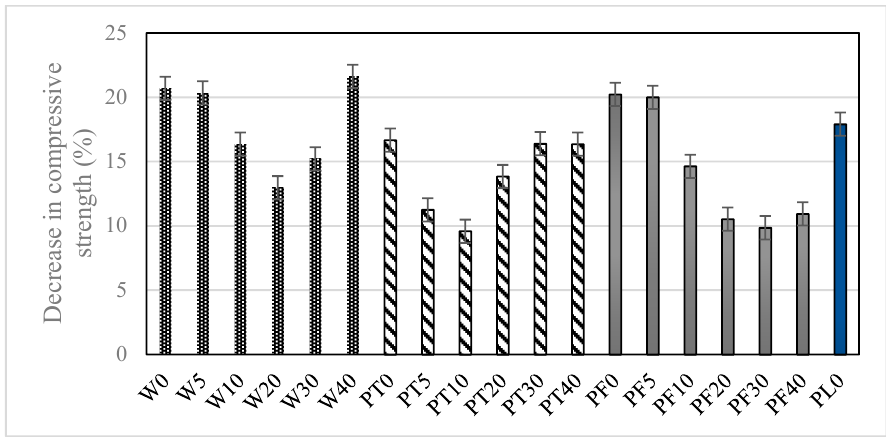
Figure 17. The f cm decrement due to 180 days SA.